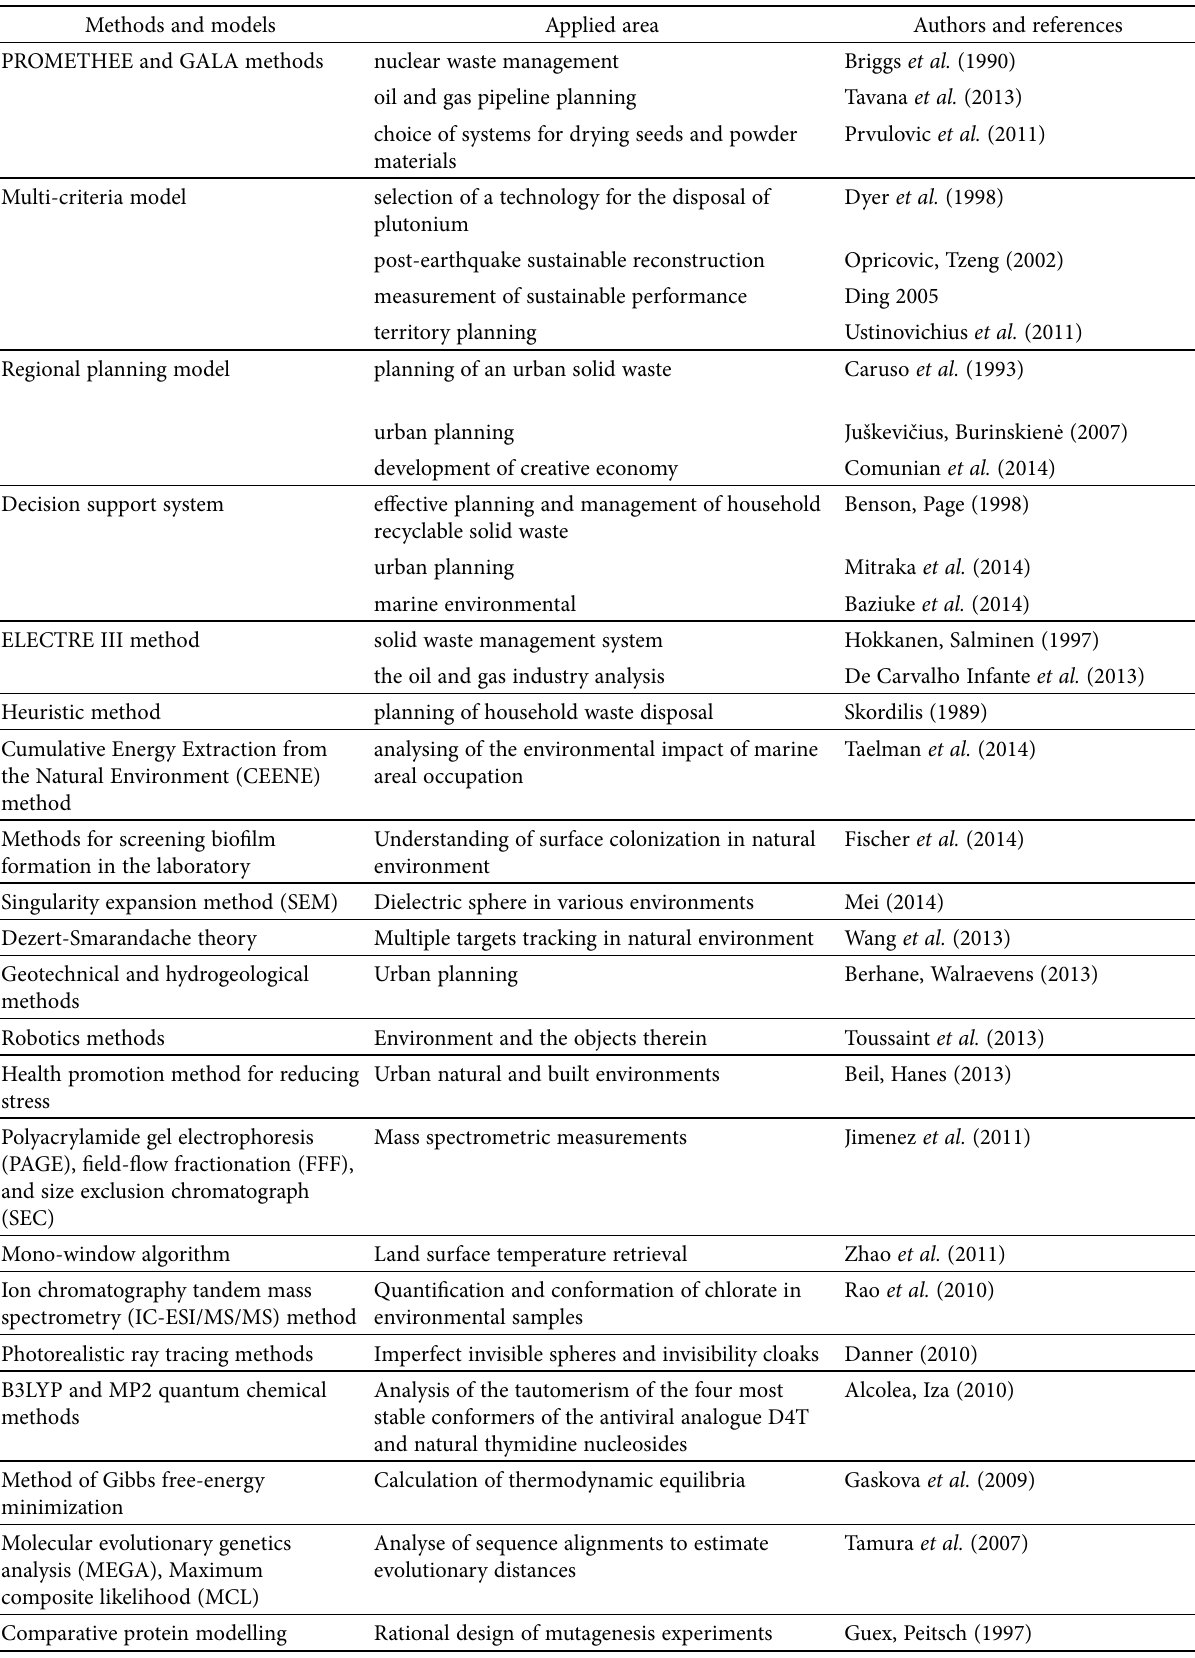
Table 2. Methods and models used in technological environmental discourse 2